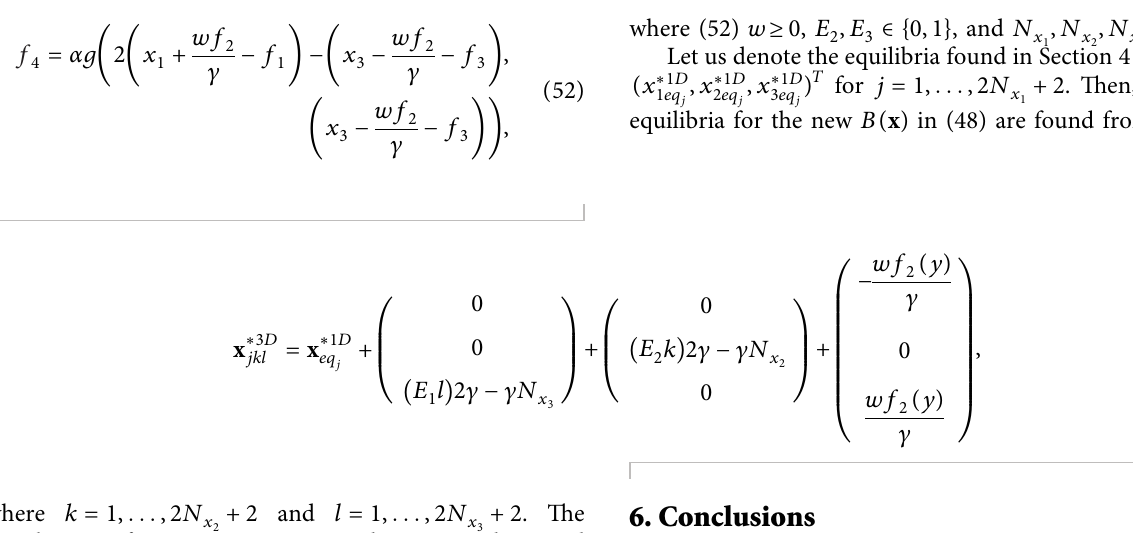
Figure 6: Simulation of the hidden attractor exhibited by system (43) with parameters a � 0 . 2, b � 5, c � − 7, and N t ∈ [ 1000000 , 10001000 ]